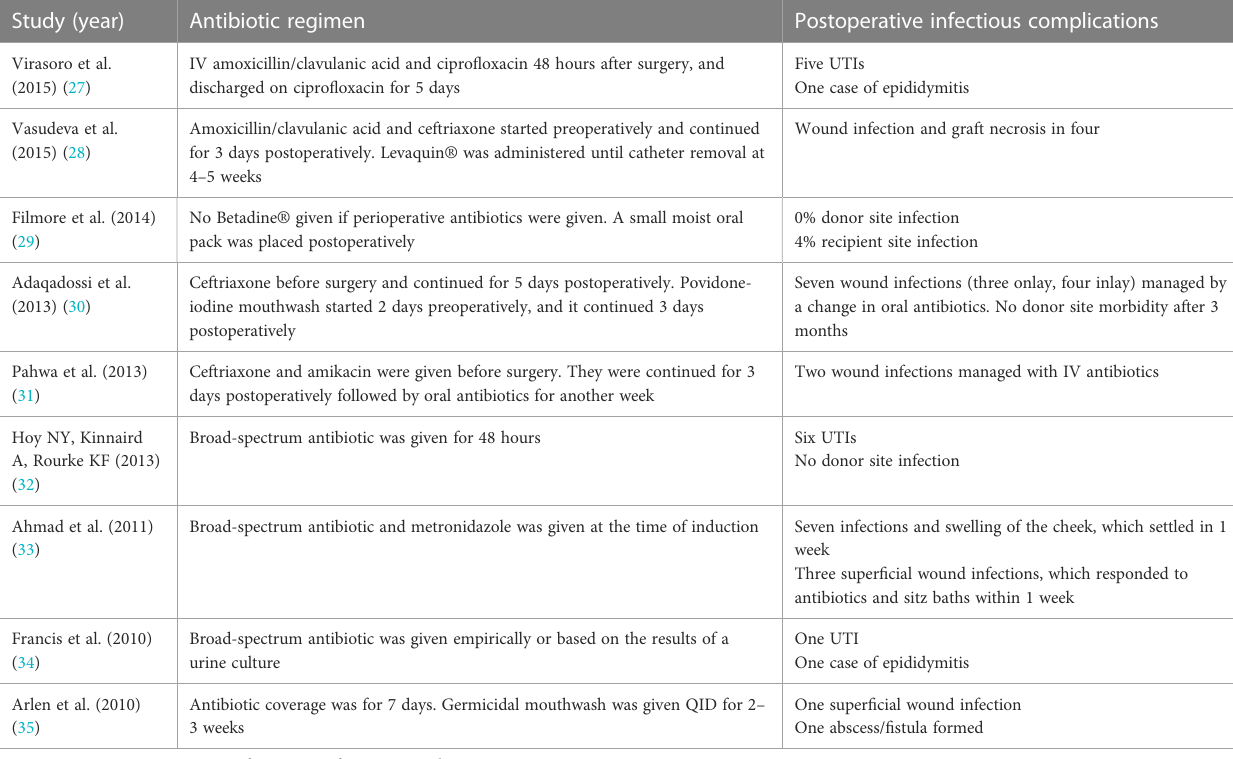
TABLE 1 Studies of BMG urethroplasty antibiotic regimens and infection rates. Study (year)